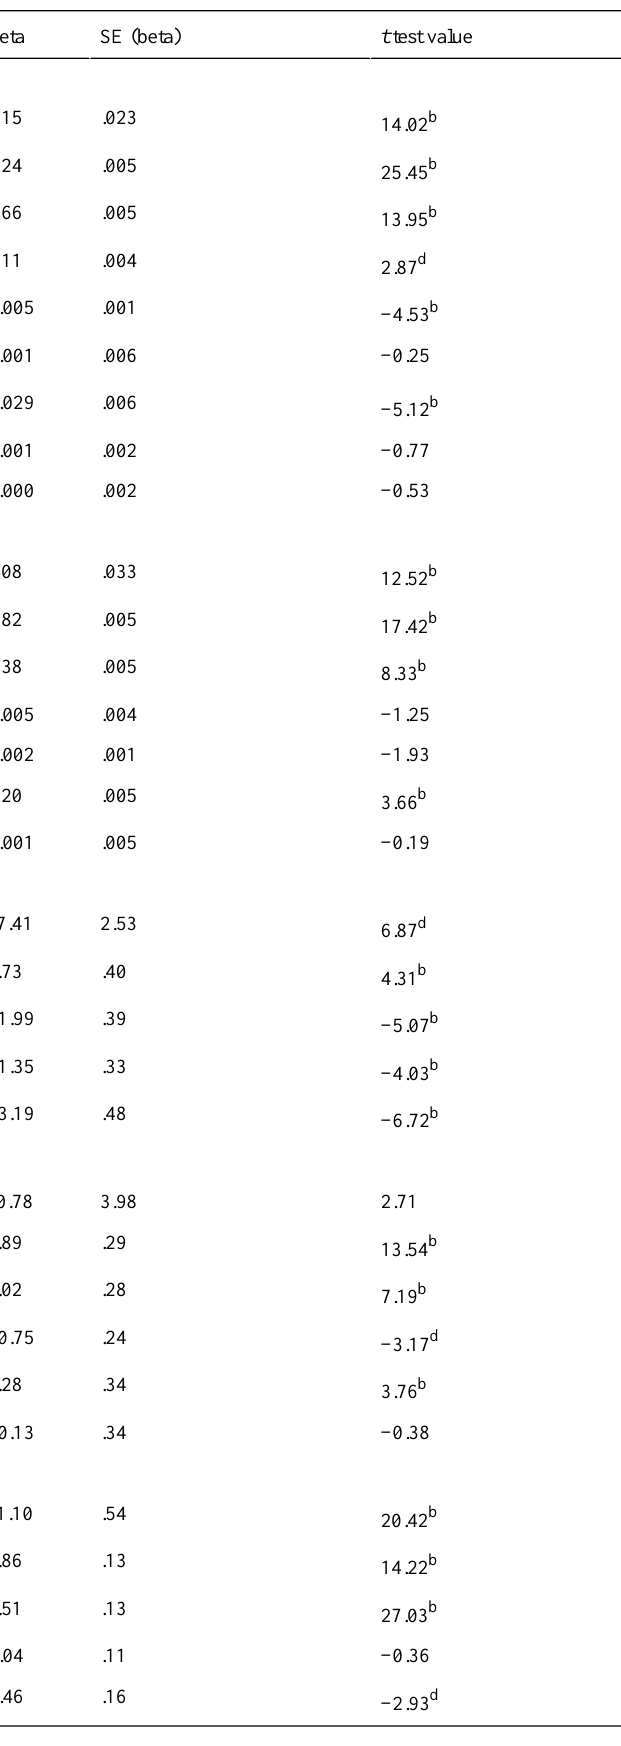
Table 3. Multi-level mixed model